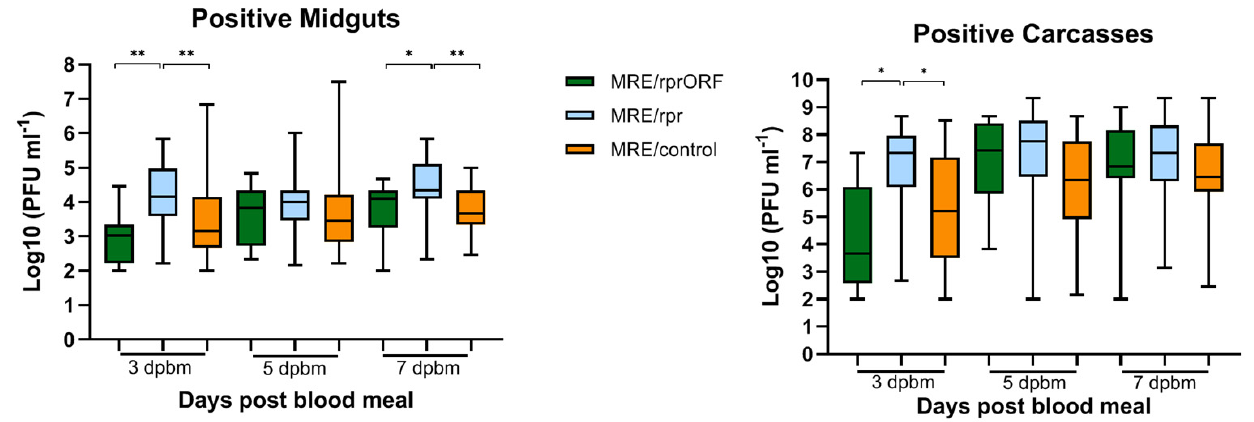
Figure 7. Mosquitoes infected with MRE/rprORF have similar titers compared to MRE/control. The titers of the infected midgut ( left ) and carcass ( right ) samples from Figure 6 are shown. Titer values were log transformed and compared by one-way ANOVA and Tukey’s multiple comparisons test. * p < 0.05, ** p < 0.01. Statistical comparisons (brackets) are shown for all statistically significant dif- ferences.